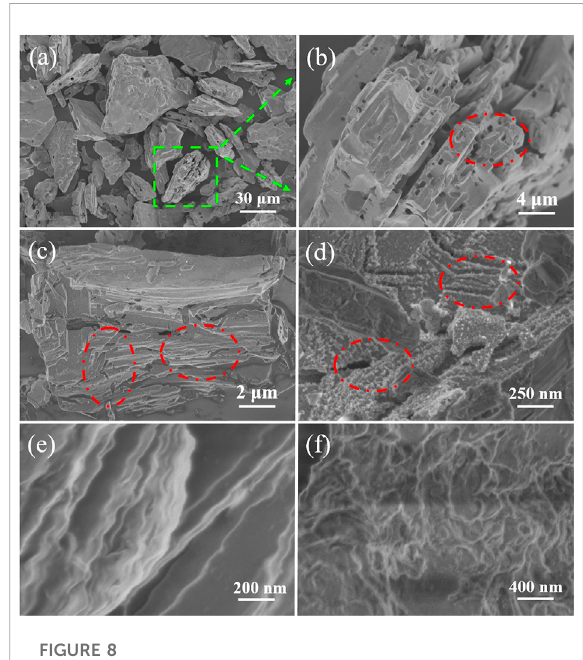
FIGURE 8 SEM images of intermediate sheets obtained by etching Ti 3 AlC 2 powders in the H 2 SO 4 /H 2 O 2 solution with different magni fi cations (A – D) , and SEM images of Ti 3 C 2 T x nanosheets with different magni fi cations (E – F)